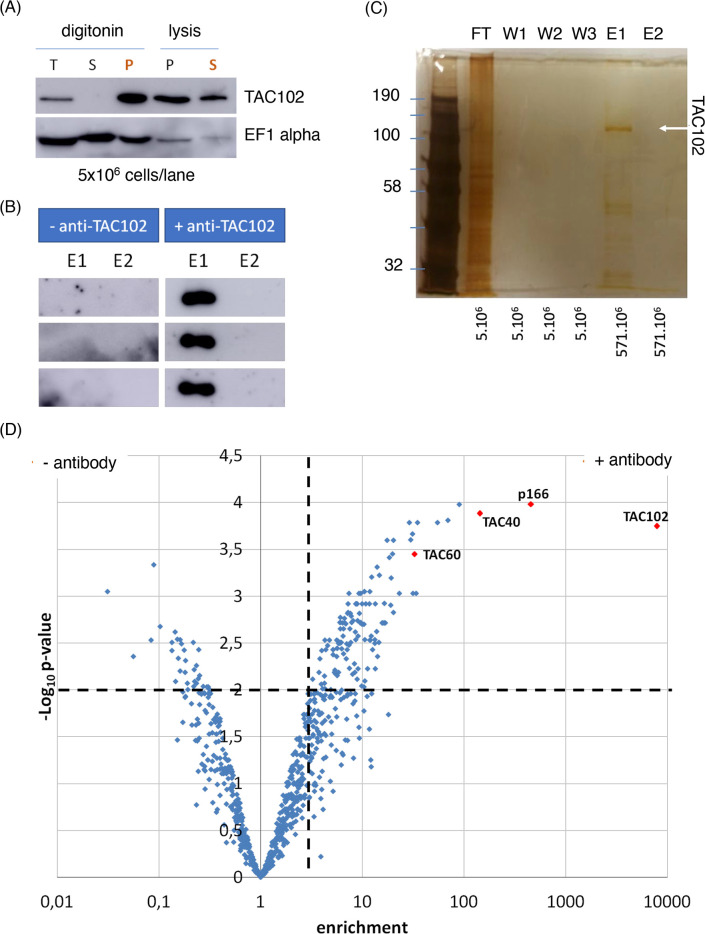
TAC102 enrichment and immunoprecipitation.The experiments were done in three independent replicates and all showed similar results. (A) Western blot analysis of the digitonin fractionation and subsequent lysis of the pellet fraction with 1% (v/v) Nonidet P-40 of whole cell protein from procyclic cells. T: total; S: supernatant; P: pellet. In orange: the pellet from the digitonin fractionation was used for the subsequent Nonidet P-40 lysis. The elongation factor EF1α served as a control. (B) Western blot analysis of the elutions (E1 and E2) of TAC102 immunoprecipitation replicates. (C) Silver stained SDS PAGE of TAC102 immunoprecipitation fractions. On the left are the molecular weights in kDa. Under each lane are written the equivalence of cells loaded. TAC102, indicated by a white arrow, was detected in E1. FT: flow-through; W1-W2-W3: washes; E1-E2: elutions. (D) Volcano plot representing the significance versus enrichment of the results from mass spectrometry analysis of TAC102 immunoprecipitation. A total of 775 proteins were identified from which 100 proteins were significantly enriched in the TAC102 immunoprecipitation (p ≤ 0.01). The two dotted lines represent the cut-off used (p ≤ 0.01 and enrichment > 3). The protein the most enriched in the condition was TAC102. Three other TAC components were also highly enriched (p166, TAC40 and TAC60).